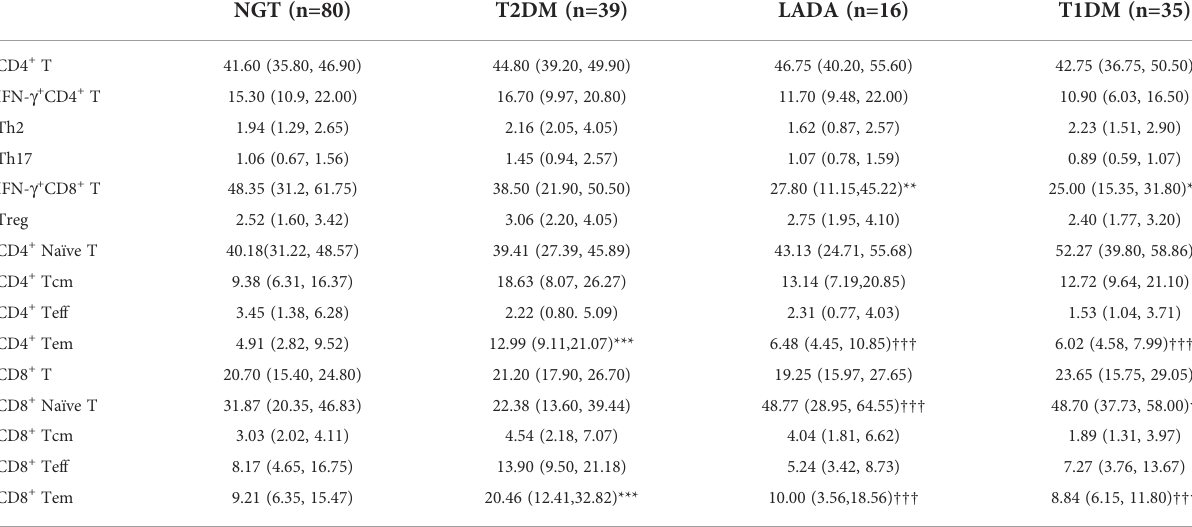
TABLE 4 T-cell subset frequencies in new-onset T1DM, LADA, and T2DM patients and NGT